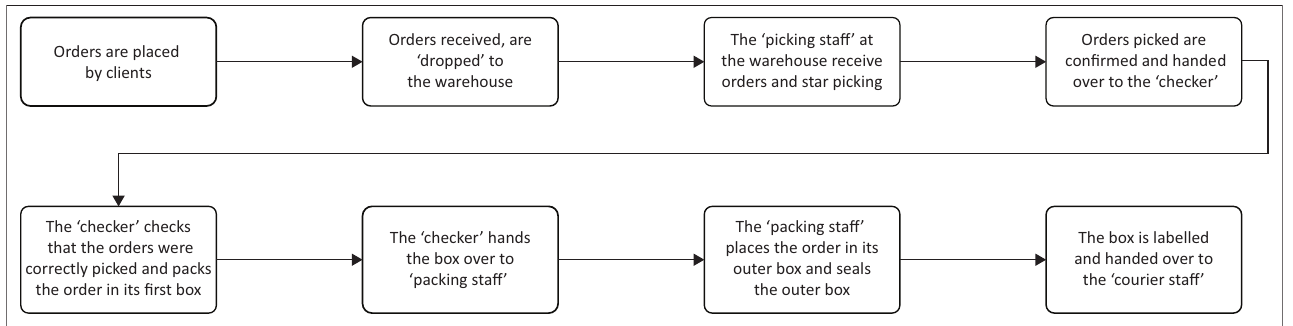
FIGURE 3: Vaccine handling processes (Aspects of toolkit element 3).